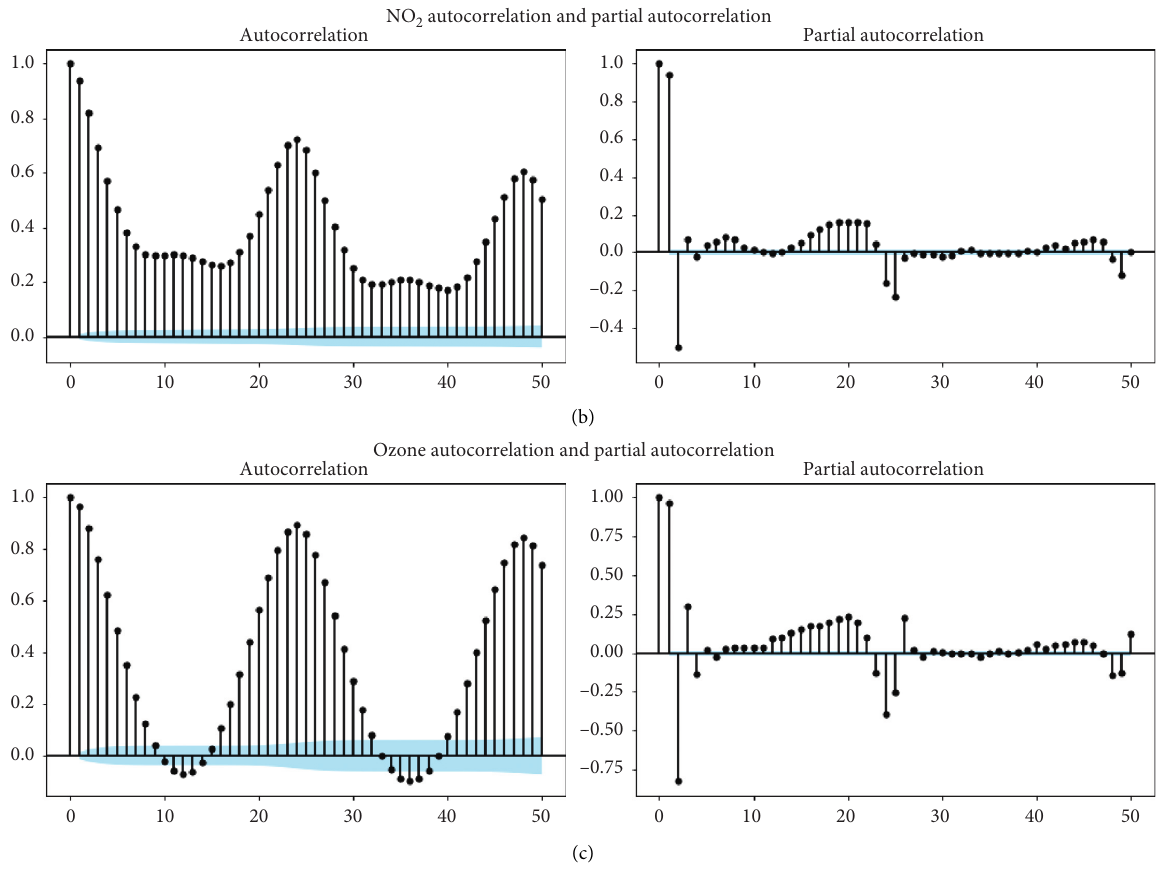
Figure 6: ACF and PACF plots for CO, NO 2 , and ozone in California. Table 4: Selected variables’ summary per target